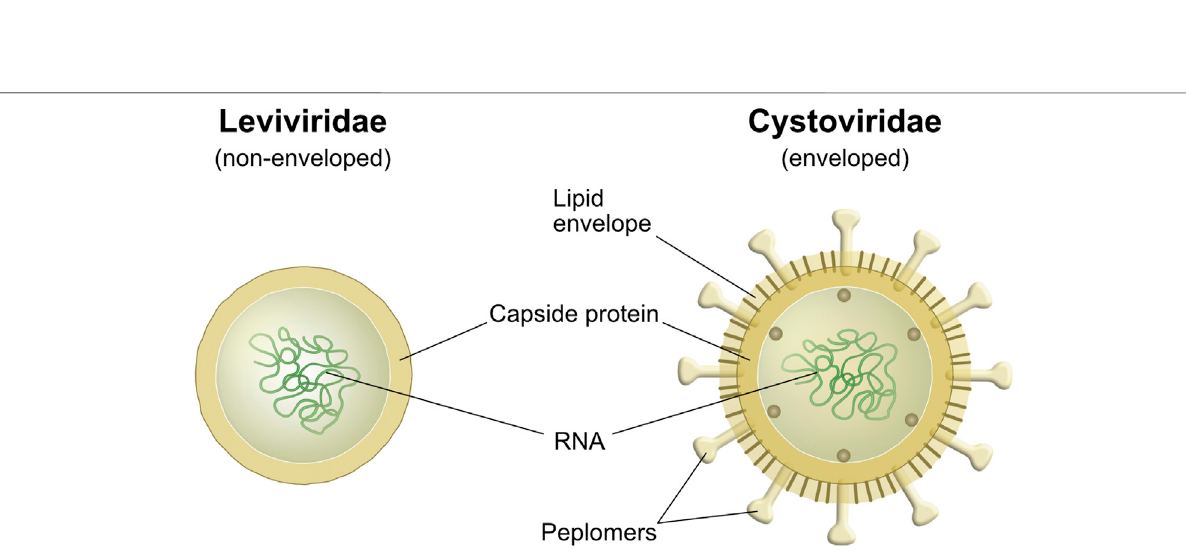
Frontiers in Chemistry |